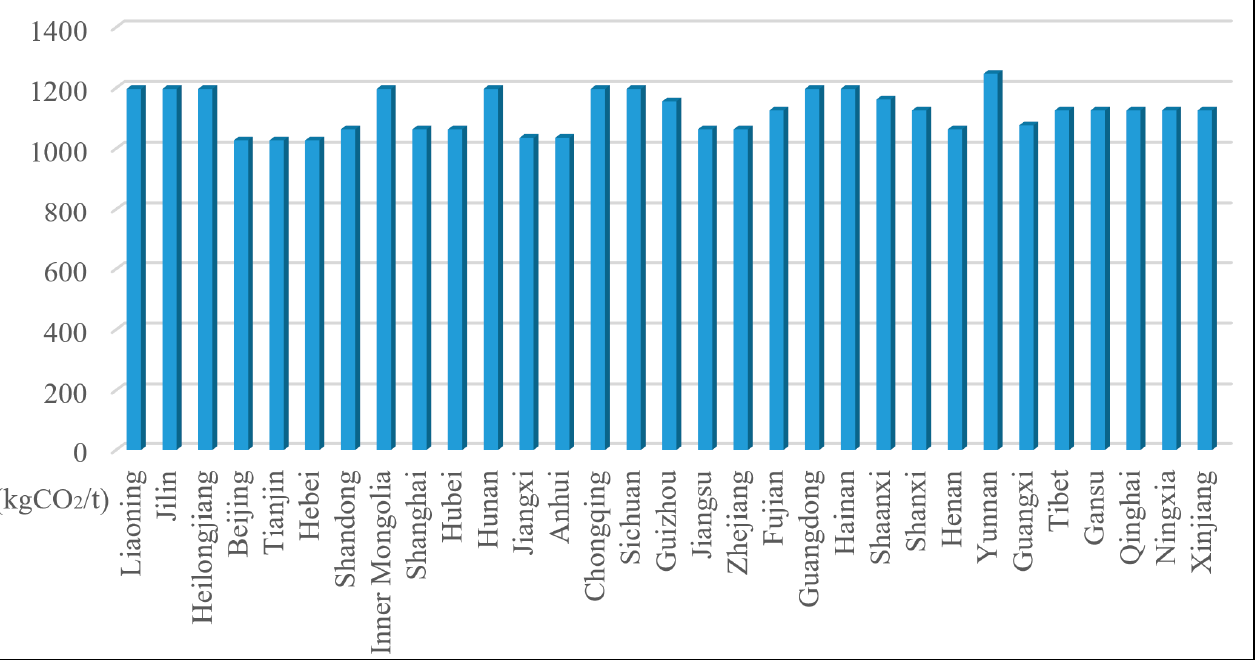
Table 2. Carbon emission factors of each pavement structure (units: kg/t).